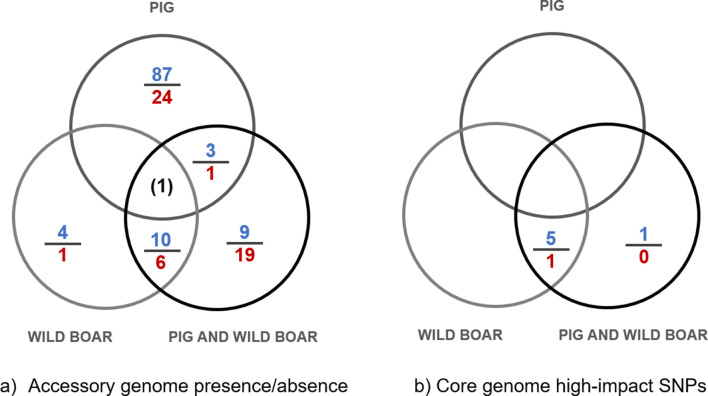
Venn diagram showing the results from Scoary testing of association between host type (pig, wild boar and all other) and (a) the presence or absence of accessory genome components (genes and gene variants), and (b) the presence or absence of high-impact SNPs in core genome genes. For each field, the number of significantly over-represented genes or gene variants (BH-corrected P<0.05) is shown in blue over the line and the number of under-represented shown in red under the line. Empty fields indicate no genes were over- or under-represented. A single gene was over-represented in boars but under-represented in two other categories (a, central field).